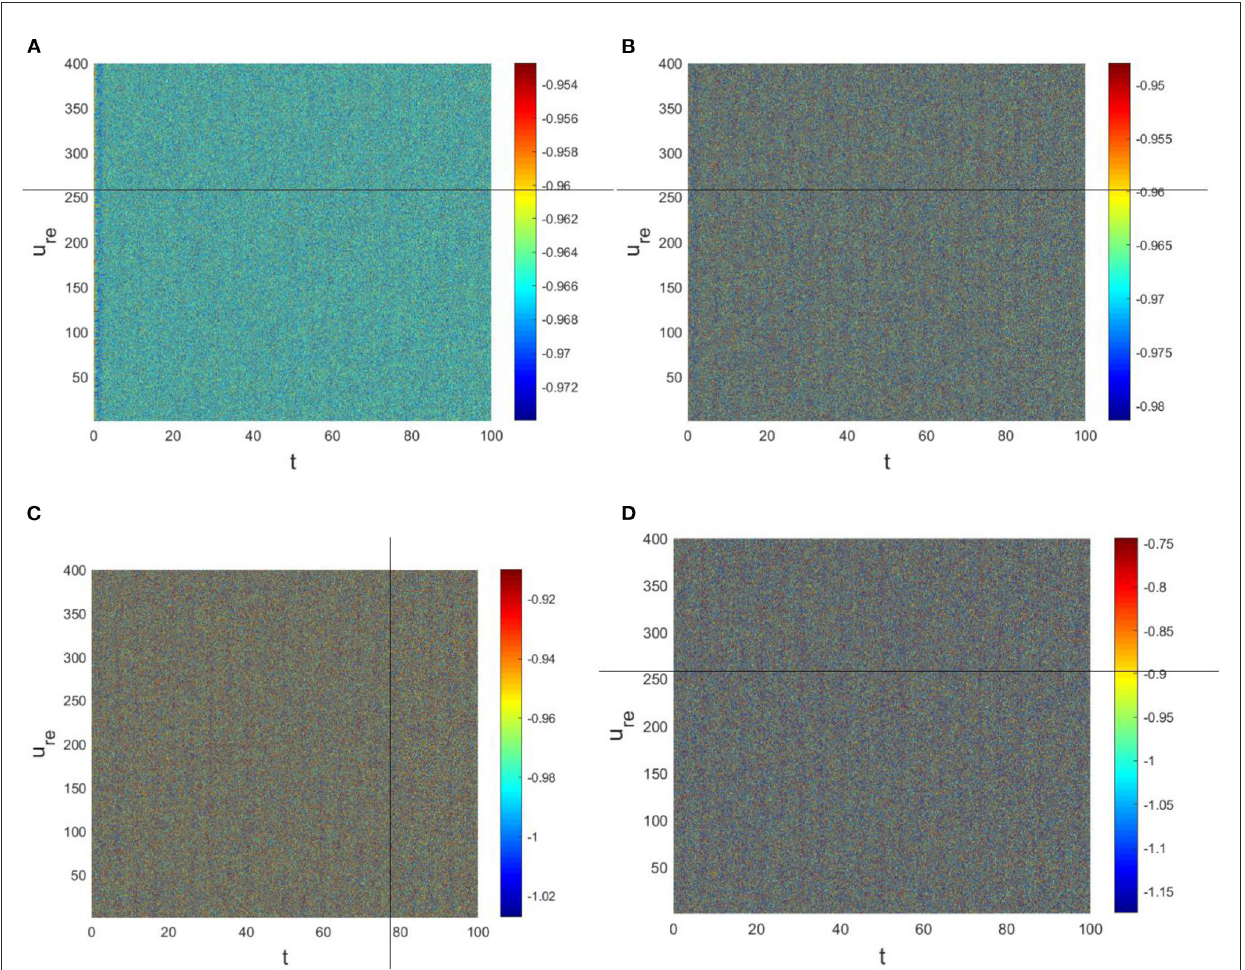
FIGURE6 Pattern with a np O (10 − 3 =